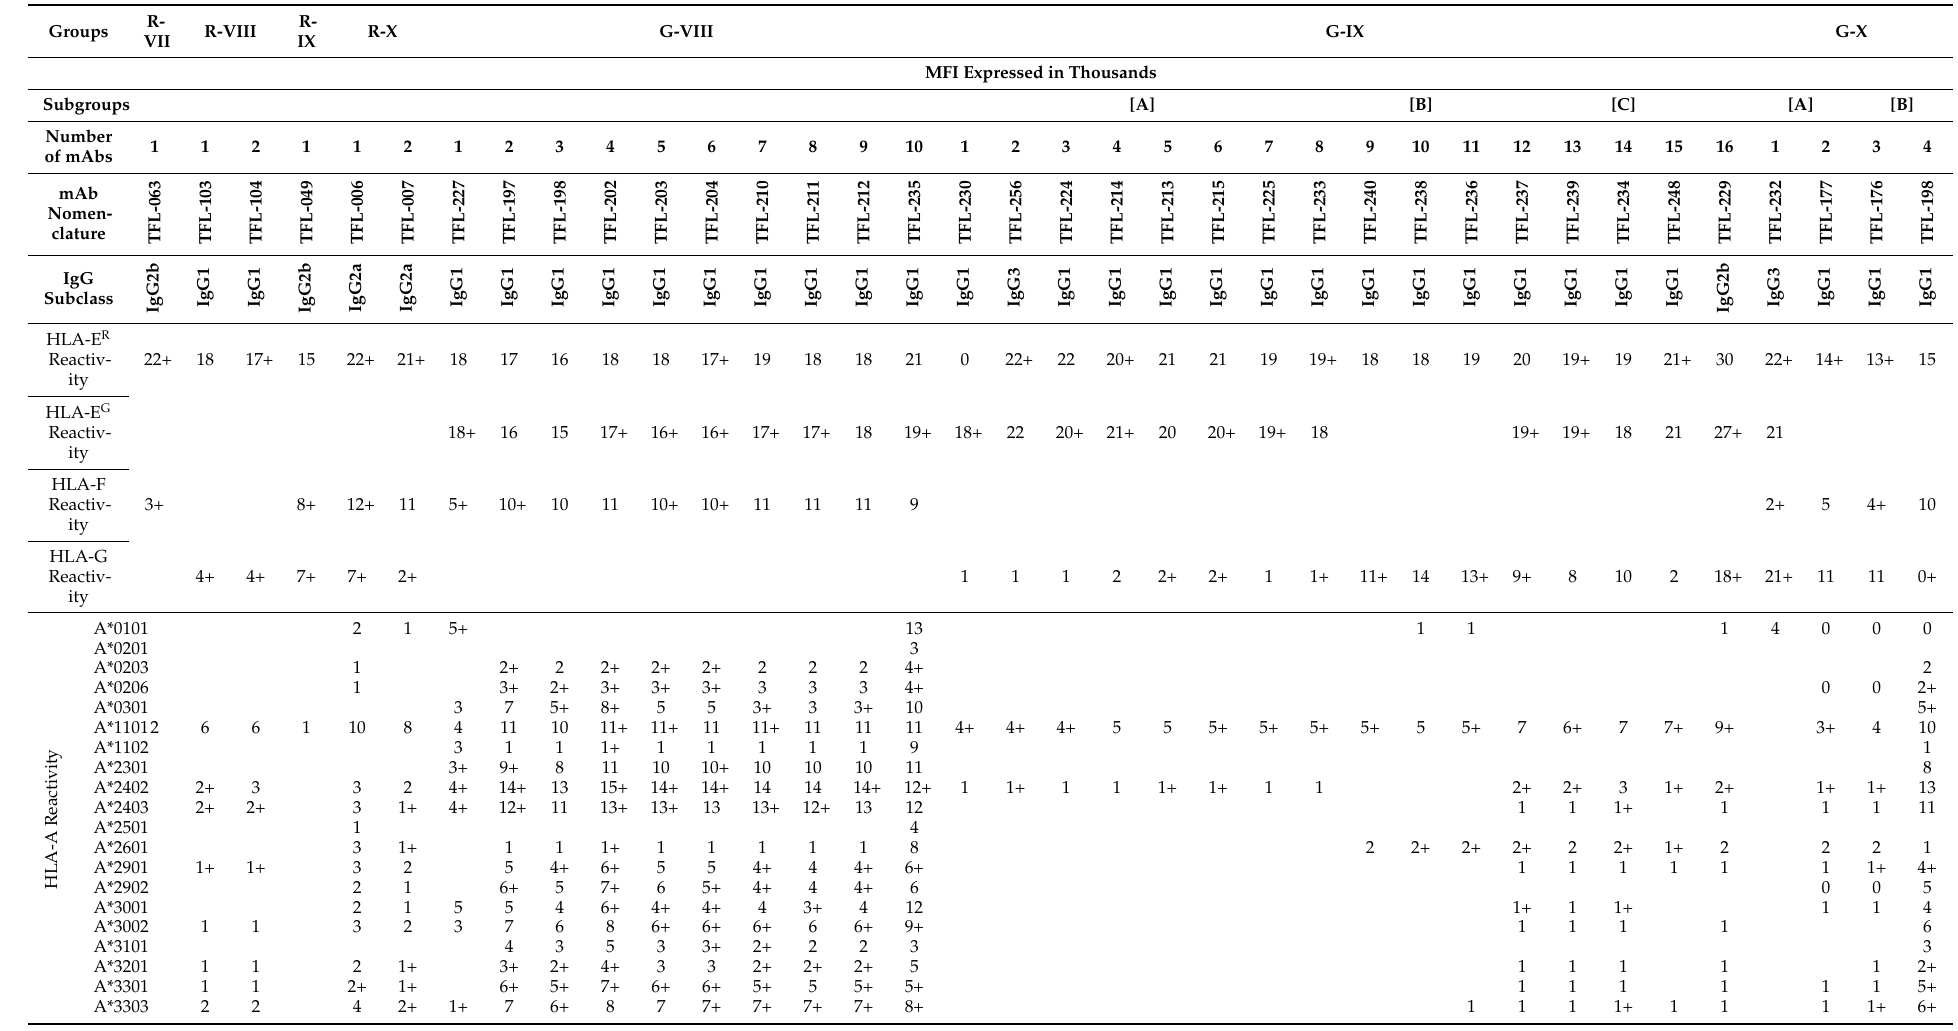
Table 9. Evolving HLA-E R and HLA-E G mAbs: HLA-Ib mAbs also react to all HLA-Ia isoform